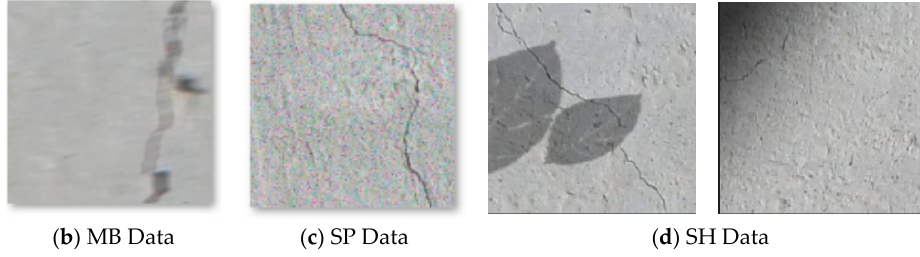
Figure 4. Normal Image data versus compromised variants.